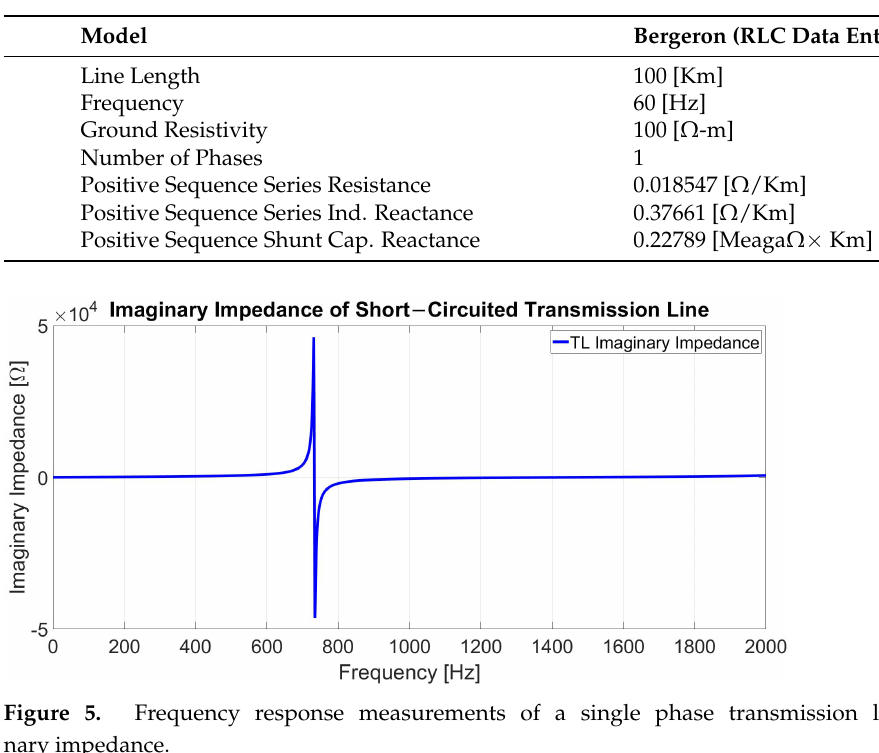
Table 4. Transmission line Bergeron model parameters.